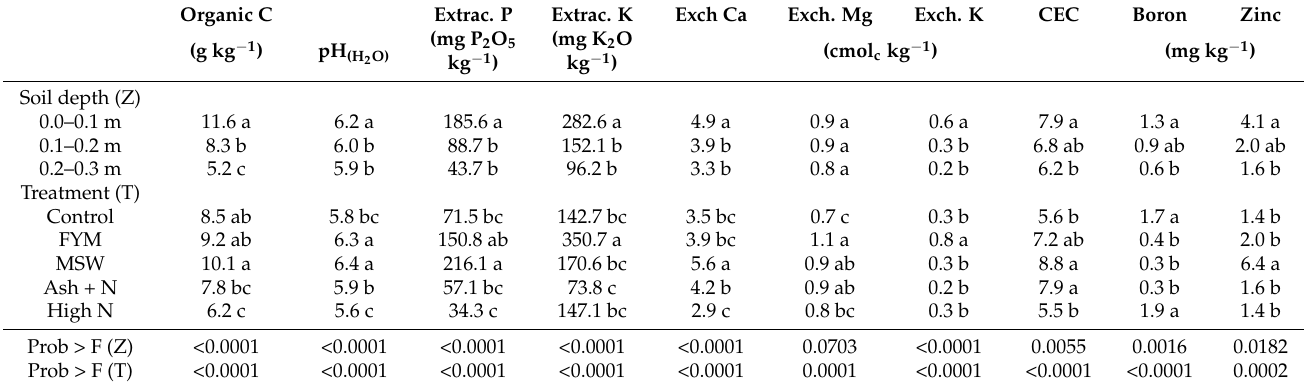
Table 4. Organic carbon (C), pH(H 2 O), extractable phosphorus (P) and potassium (K), exchangeable calcium (Ca), magne- sium (Mg) and K, cation exchange capacity (CEC) and extractable boron and zinc in soil samples taken in June 2020. Organic C Extrac. P Extrac. K Exch Ca Exch. Mg Exch. K CEC Boron Zinc